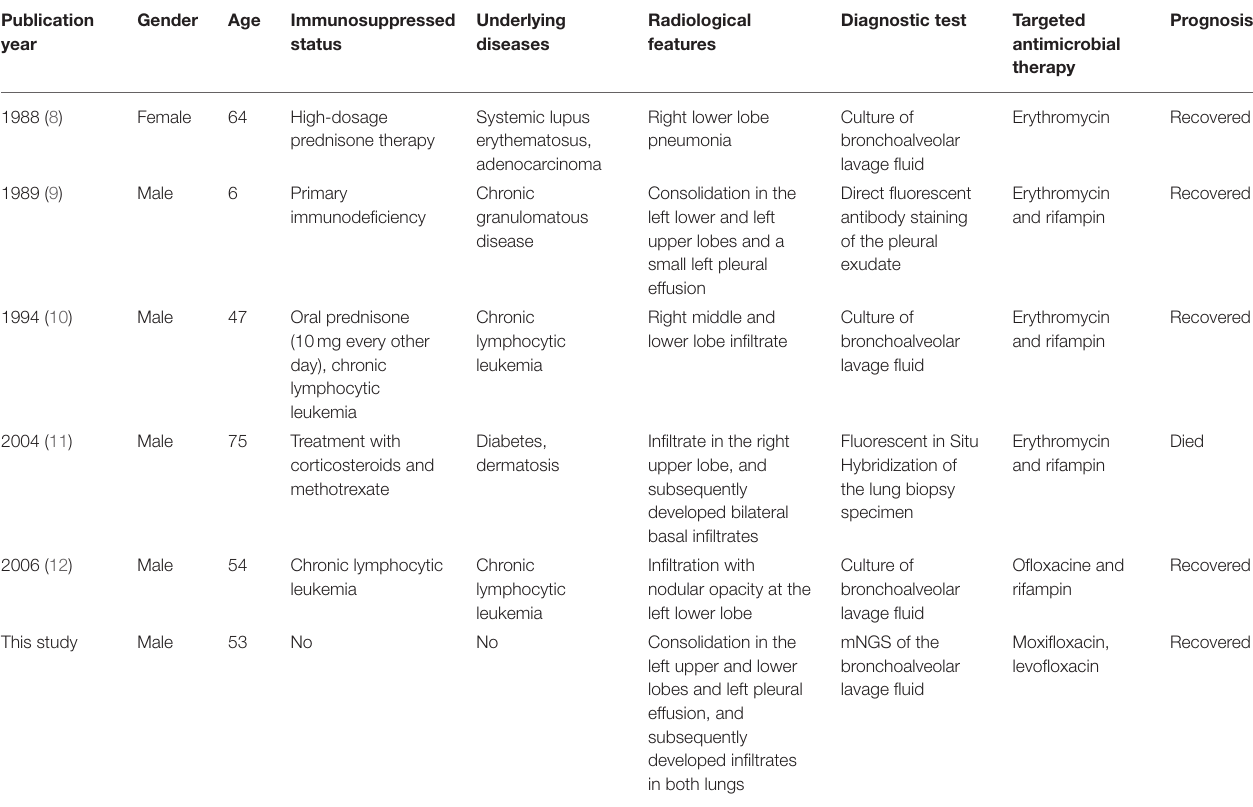
TABLE 1 | Summary of cases with Legionella gormanii